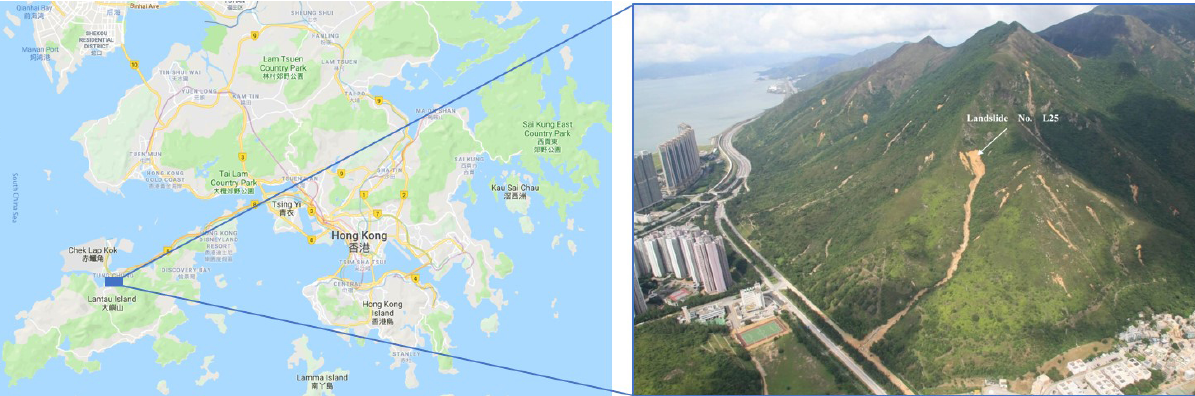
Sect. 5.1). The µ , σ , and RMSE according to Eqs. (7)